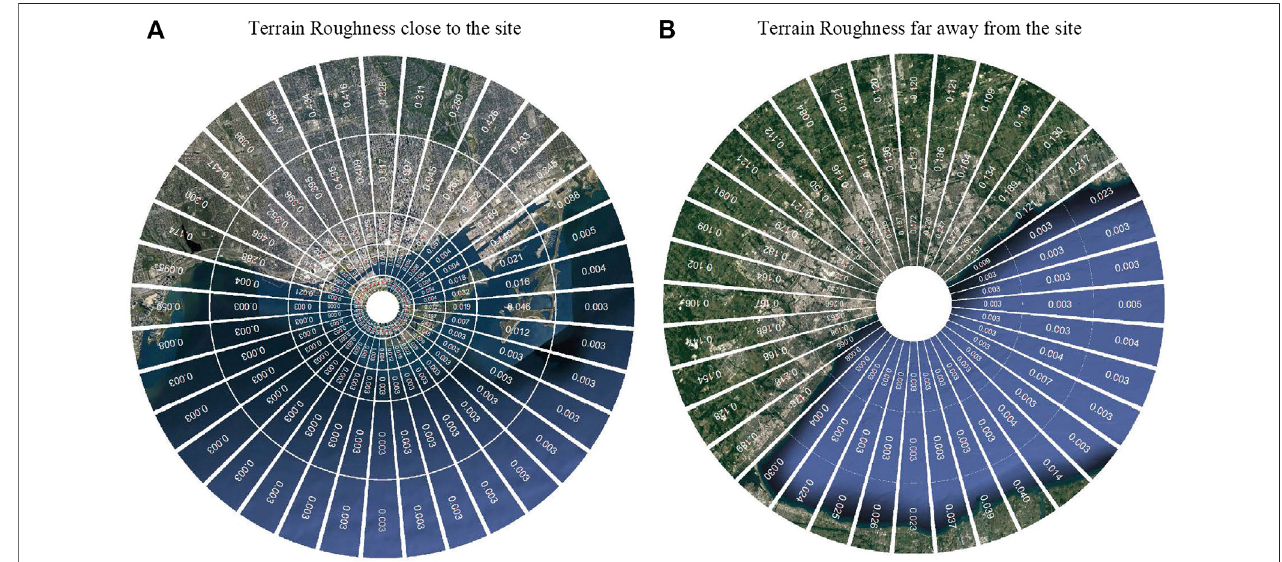
FIGURE 2 | Upstream roughness for YTZ